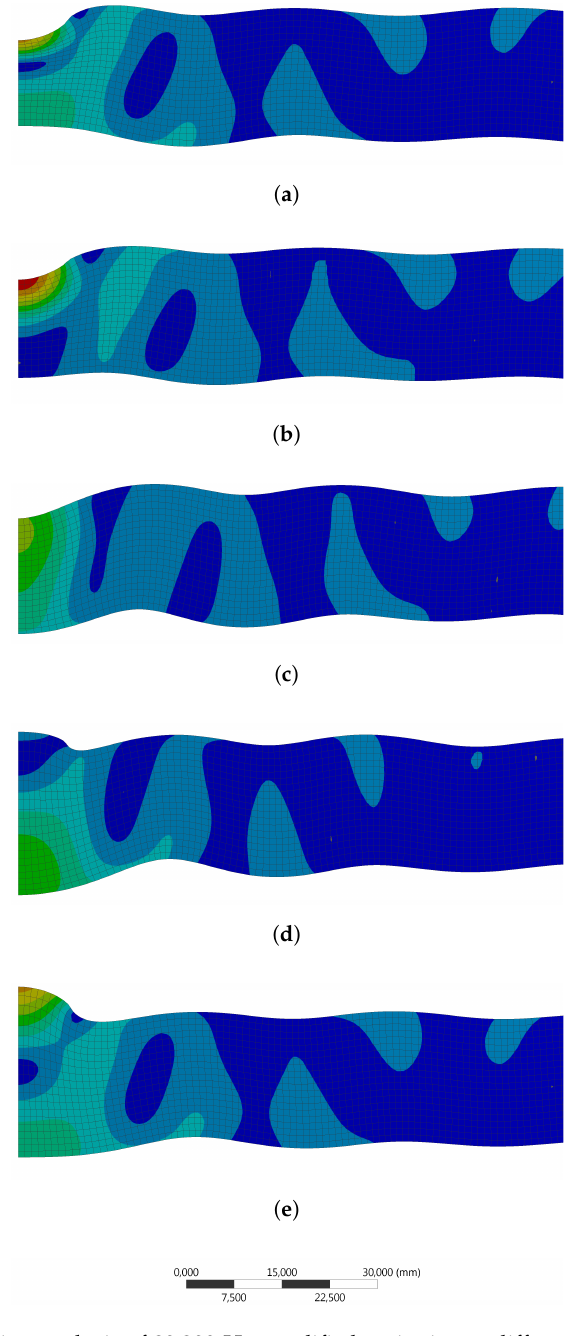
Figure 5. FEM vibration analysis of 80,300-Hz amplified excitation at different phase angles with a 1-mm ring element-size; center left-plate continues to the right. ( a ) 0 ◦ ; ( b ) 45 ◦ ; ( c ) 90 ◦ ; ( d ) 135 ◦ ; ( e ) 180 ◦